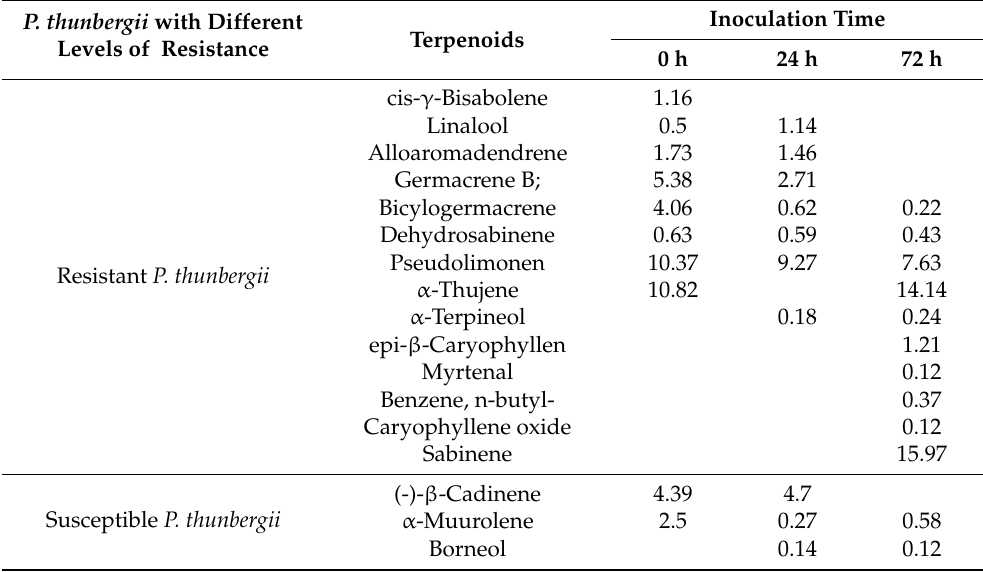
Table 3. Specific and induced terpenoids and their contents (%) in P. thunbergii with different levels of resistance in the early stages of PWN